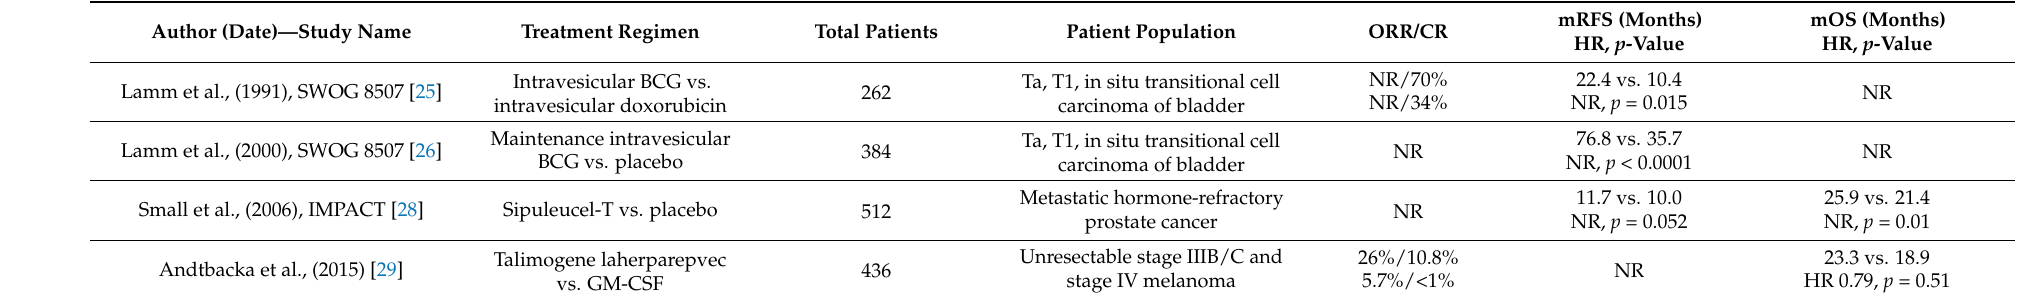
Table 1. Approved Vaccine-Based Therapies in